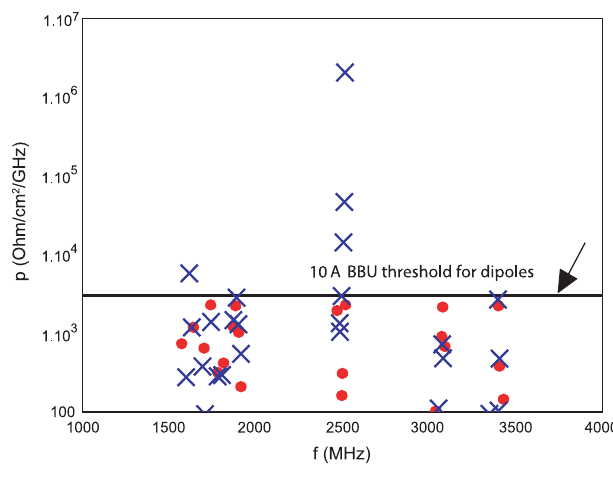
FIG. 23. (Color) BBU parameter p vs frequency for the cavity with minimal fundamental losses before and after optimization for minimal p .